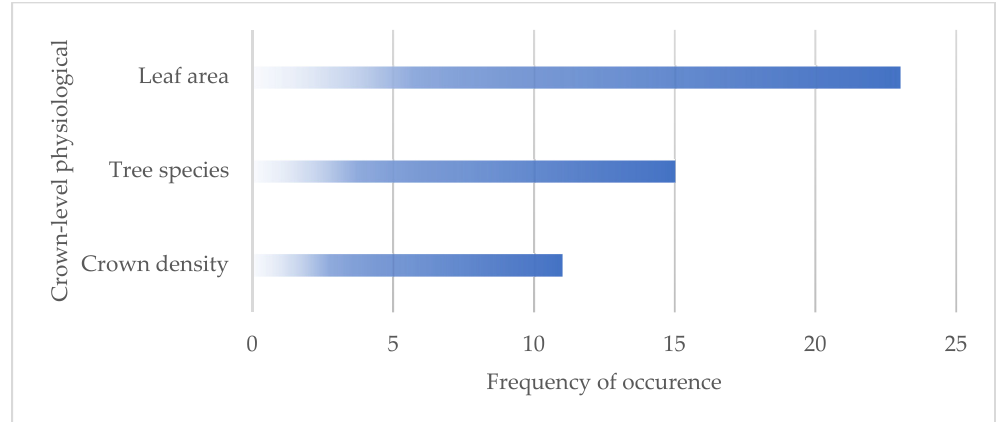
Figure 3. Frequency of occurrence of trees’ crown-level physiological characteristics in the 48 papers analyzed.